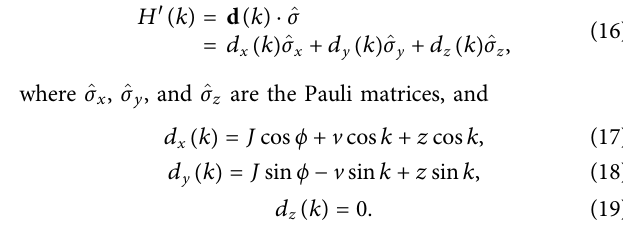
FIGURE 2 | (Color online) Phase diagram of the generalized SSH model with ϕ (cid:1) 0. The winding number is: W (cid:1) 1 if z > v and z + v > J ; W (cid:1) − 1 if z < v and z + v > J ; or W (cid:1) 0 if z + v < J .